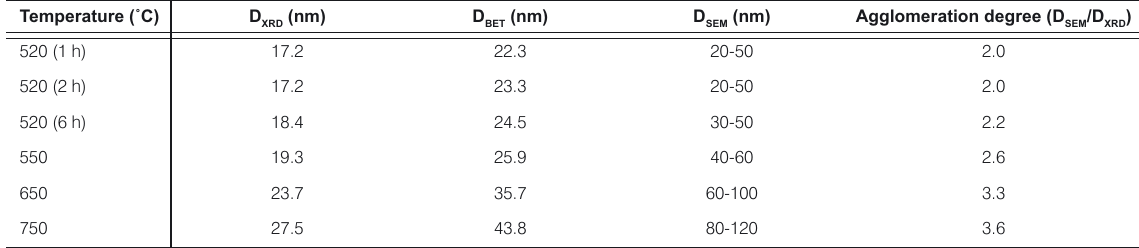
Table 1. Dependence of particle size on calcination temperature and heat treatment time determined by SEM, XRD and BET.